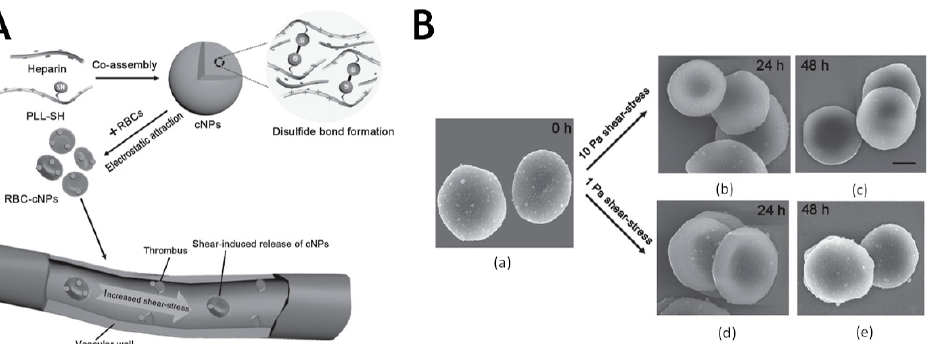
Figure 4. ( A ) Schematic illustration showing the preparation process of red blood cell adsorbed cNPs (RBC-cNPs) and the change of shear stress/rheology at the thrombus site can induce the release of cNPs. ( B ) SEM images of RBC-cNPs under 1 or 10 Pa shear-stress treatment for 24 and 48 h. ( a ) SEM image of RBC-adsorbed cNPs (RBC-cNPs) under static condition. SEM images of RBC-cNPs under 10 Pa shear-stress treatment for ( b ) 24 and ( c ) 48 h. SEM images of RBC-cNPs under 1 Pa shear-stress treatment for ( d ) 24 and ( e ) 48 h. Reproduced with permission [61]. Copyright 2016,